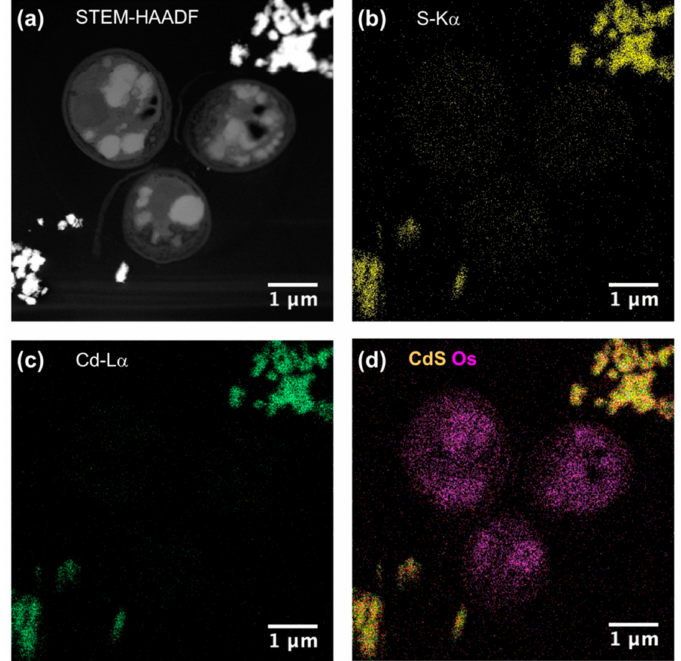
Figure 10. ( a ) STEM-HAADF and ( b – d ) STEM-XEDS images of Chlorella vulgaris ultrastructure after contact with CdS–1 nanoparticles (10 –3 M) in Seine river.